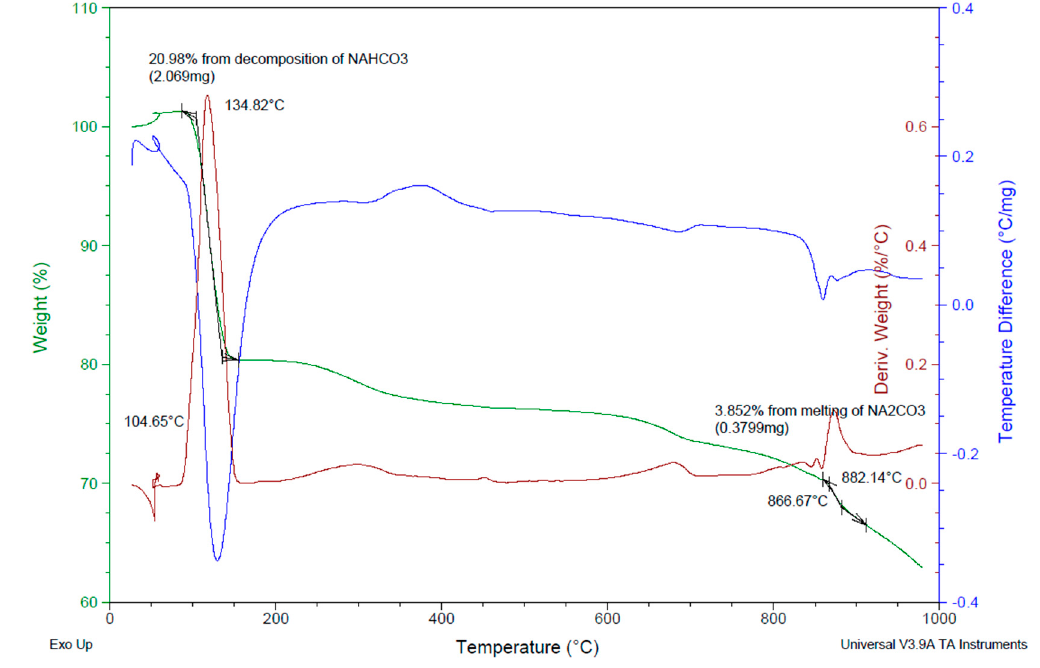
ffl orescence appearing on WGN Figure 8. TG-DTA analysis of the efflorescence appearing on WGN mortars. Figure 8. TG-DTA analysis of the e